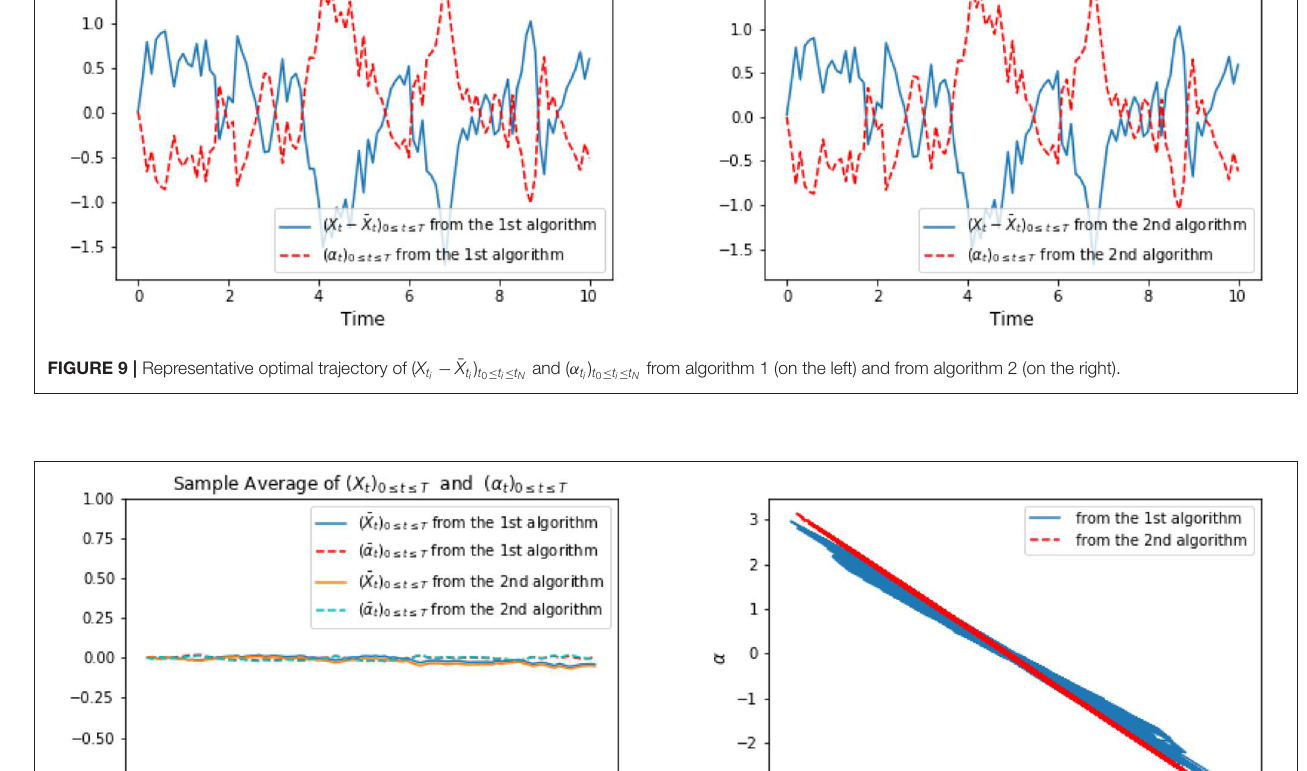
FIGURE 10 | The picture on the left plots the sample averages of ( X t against α for both algorithms.